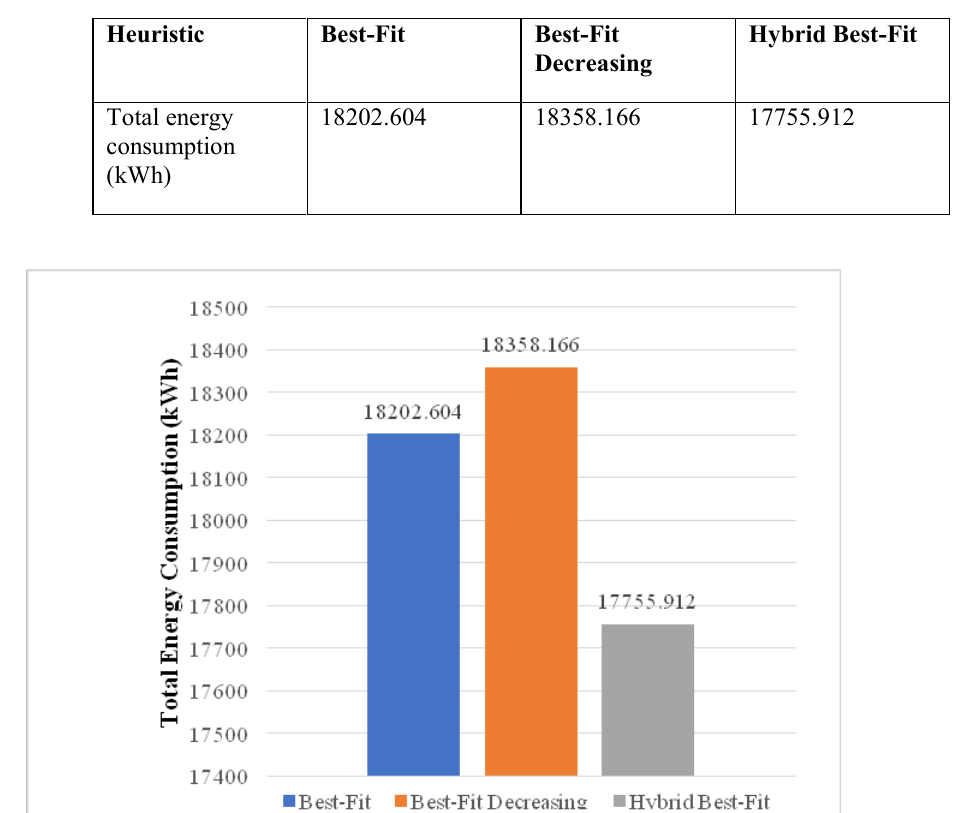
Table 1. A comparison of energy consumption by heuristics